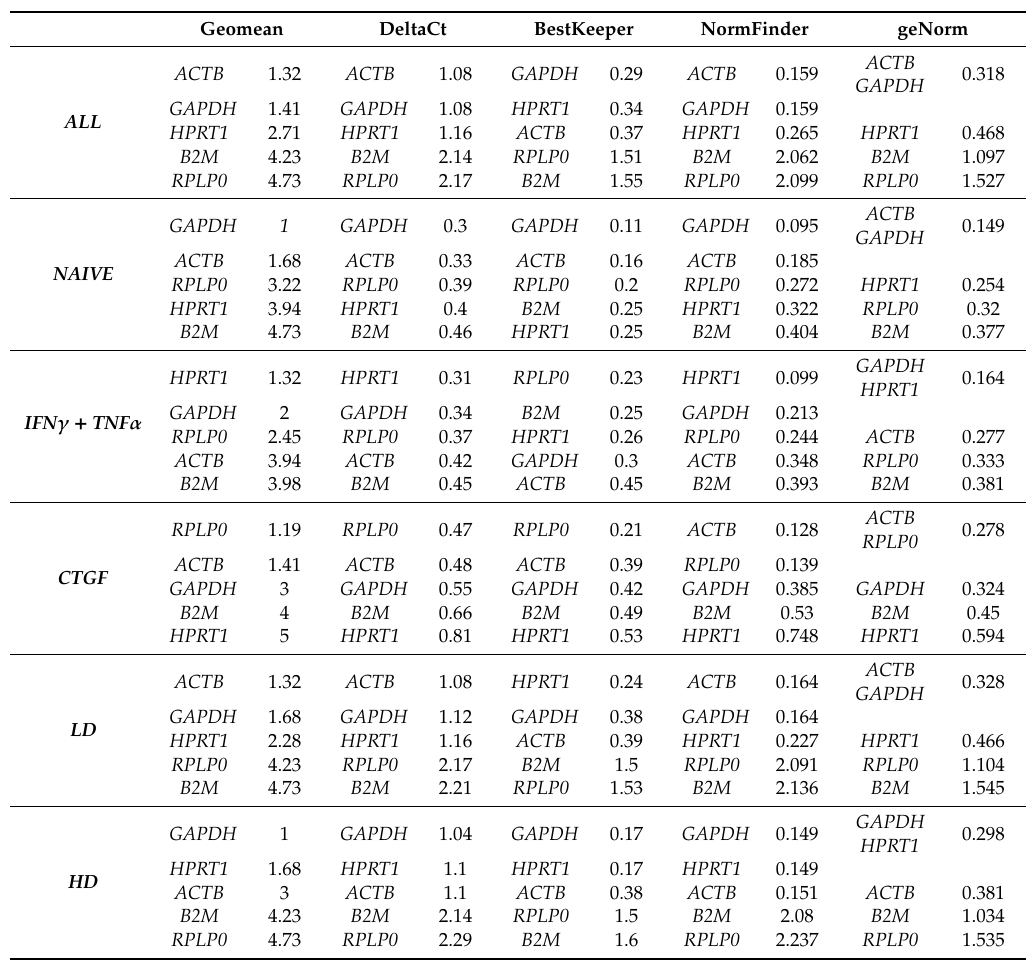
Table 2. Stability rankings of tested